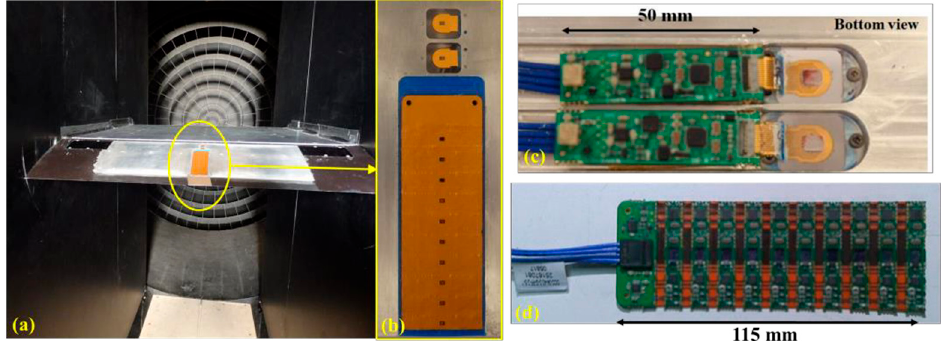
Figure 4. ( a ) Flap model equipped with twelve calorimetric micro-sensor placed along the cord ( b ) Zoom on the micro-sensors: two single micro-sensors and a flexible strip with 10 micro-sensors ( c